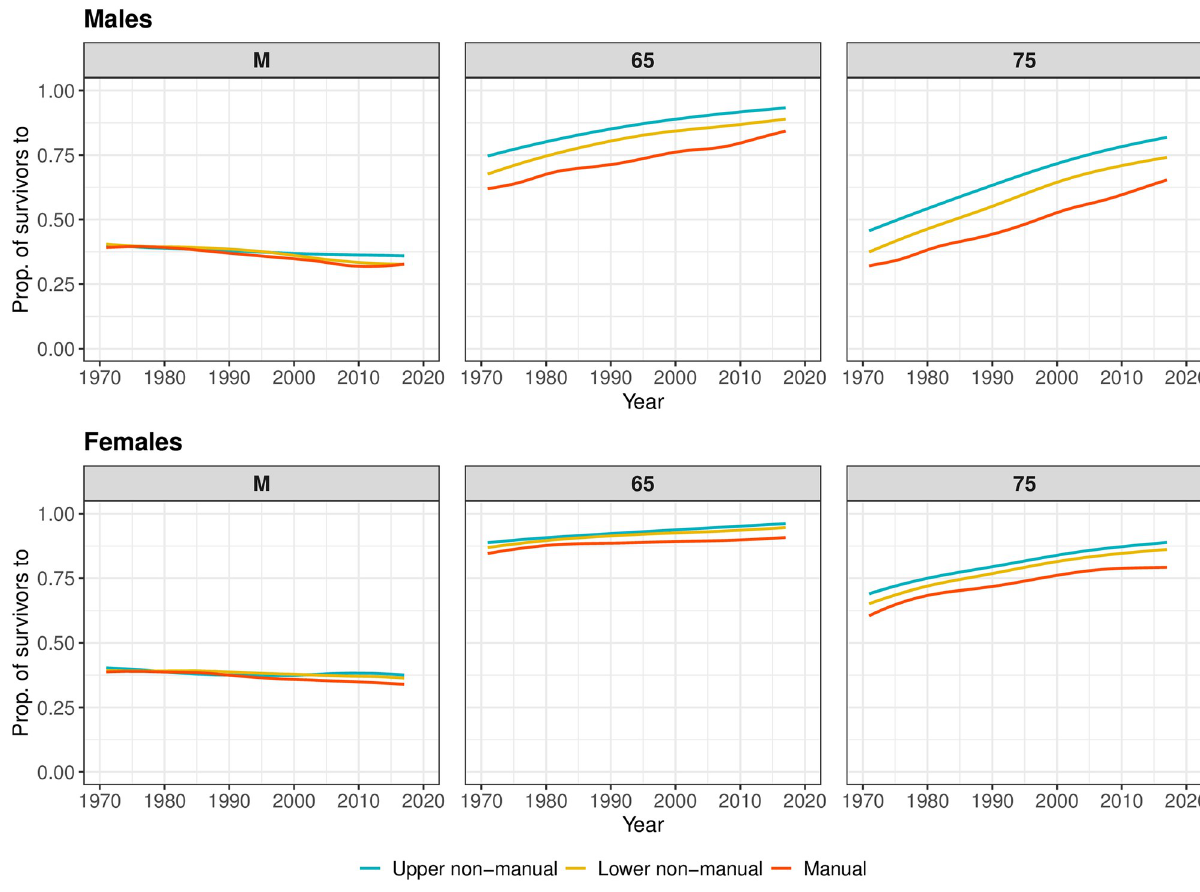
Fig 3. Proportion of 31 years olds surviving to M , 65, and 75, based on smoothed period mortality data, by occupational class and sex, Finland, 1971–2017. Smoothing was based on ages above 31.